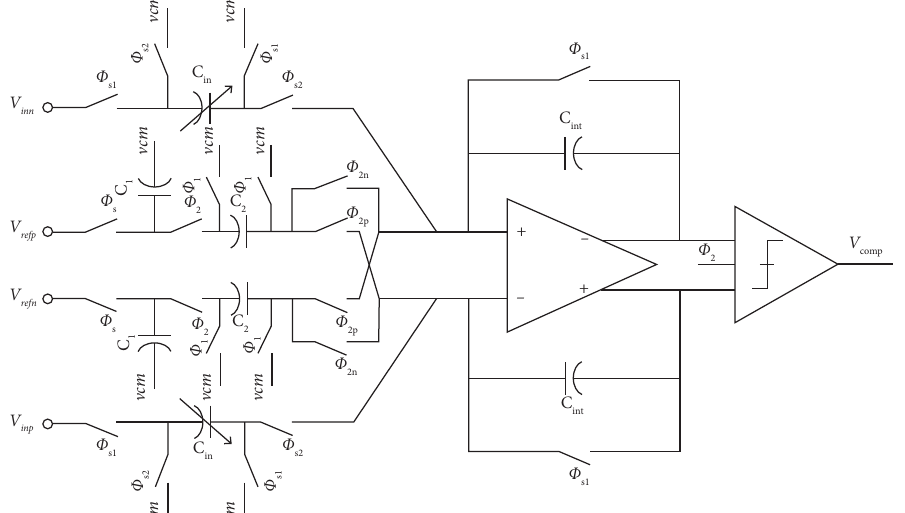
Figure 23: Te schematic of the SC integrator [62].